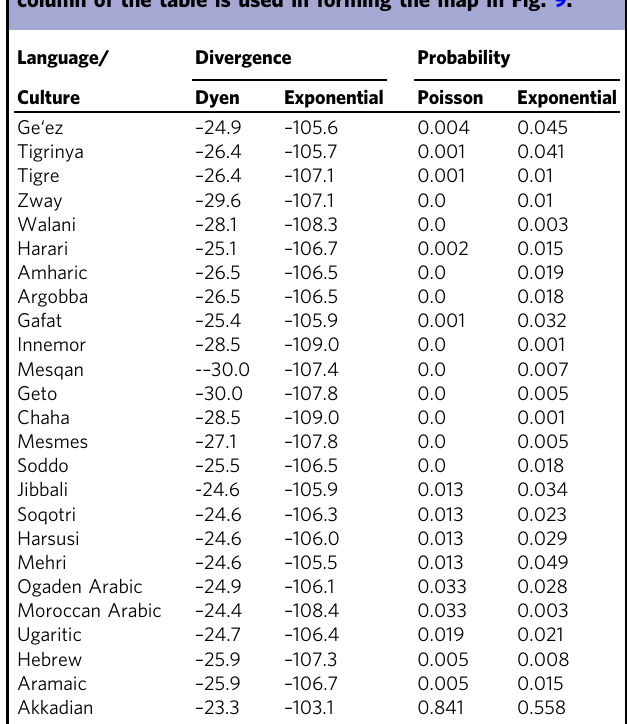
Table 1 Semitic languages-cultures with divergence measures and probabilities of point of origin. The last column of the table is used in forming the map in Fig.